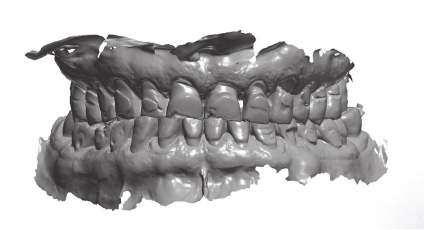
Figure 2: 3D image of the preoperative situation originated from the intraoral